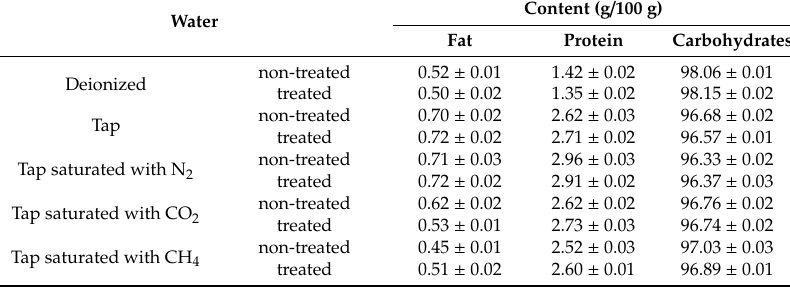
Table 2. Fat, protein and carbohydrate content in the cress watered with water saturated with N 2 , CH 4 or CO 2 prior and after their treatment with